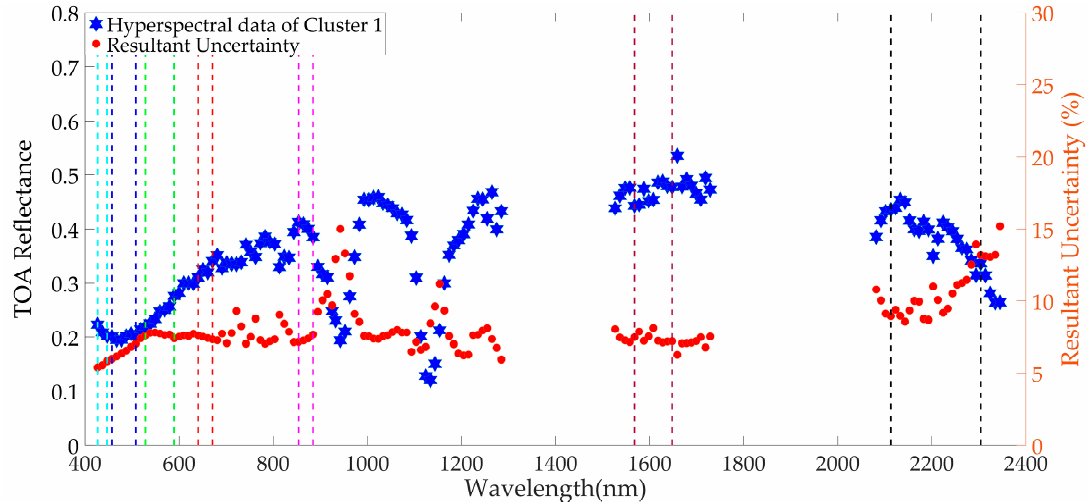
Figure 16. Estimated representative hyperspectral profile of Cluster 1 and its resultant uncertainty.